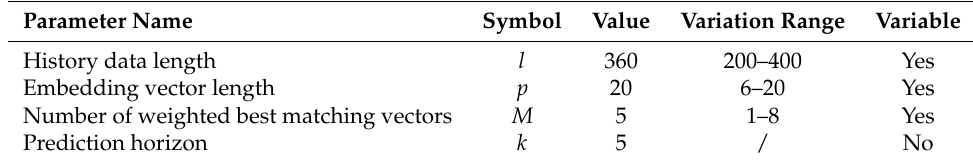
Table 2. Basic parameters for parameter